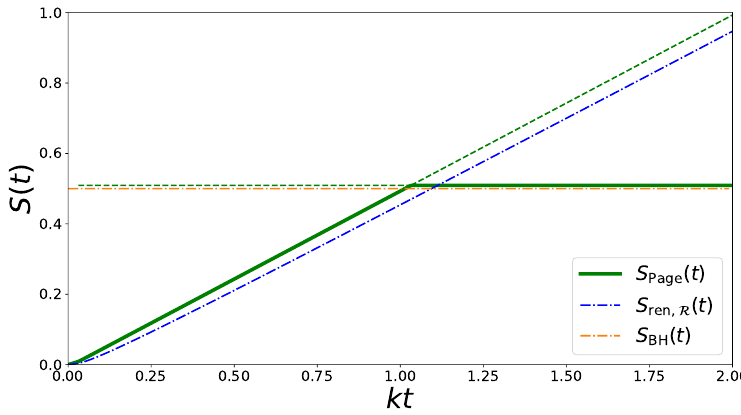
for a non-evaporating black hole is given by the Figure 13 . The Page curve for k = 0 . 01 , T = 1 2 π solid line in green. For t = 3 . 057 one finds the same constant part of the Page curve via (A.5). scr There is a small shift to a smaller Page time when compared with the intersection of the fine-grained radiation entropy and the classical Bekenstein-Hawking entropy when deviating from the strict macroscopic k/T (cid:28) 1